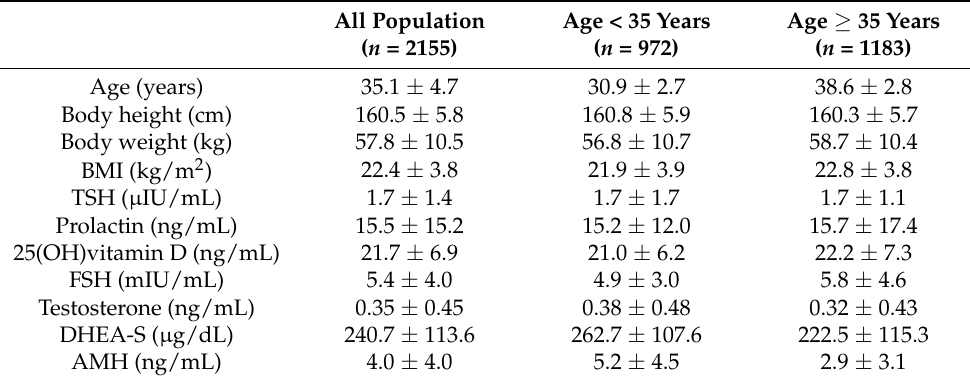
Table 1. The characteristics of the study